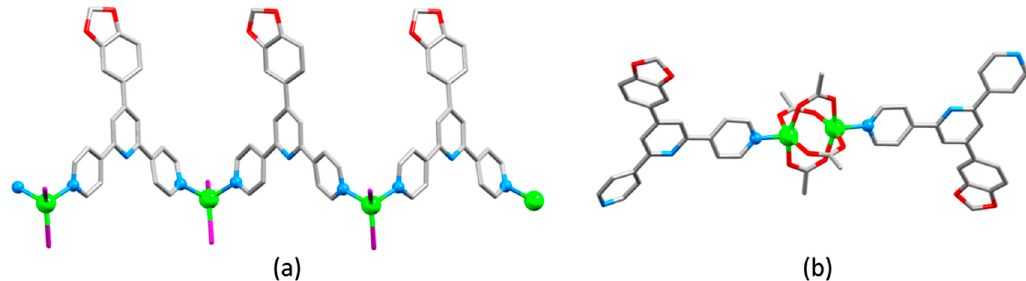
Figure 29. ( a ) Part of the 1D-polymer in [Zn( 47 )I 2 ] n (CSD refcode QOTSAV), and ( b ) the structure of the discrete complex Figure 29. (a) Part of the 1D ‐ polymer in [Zn( 47 )I 2 ] n (CSD refcode QOTSAV), and (b) the structure of the discrete complex [Zn 2 ( µ -OAc) 4 ( 47 ) 2 ] (refcode QOTRUO). [Zn 2 ( μ‐ OAc) 4 ( 47 ) 2 ] (refcode QOTRUO).